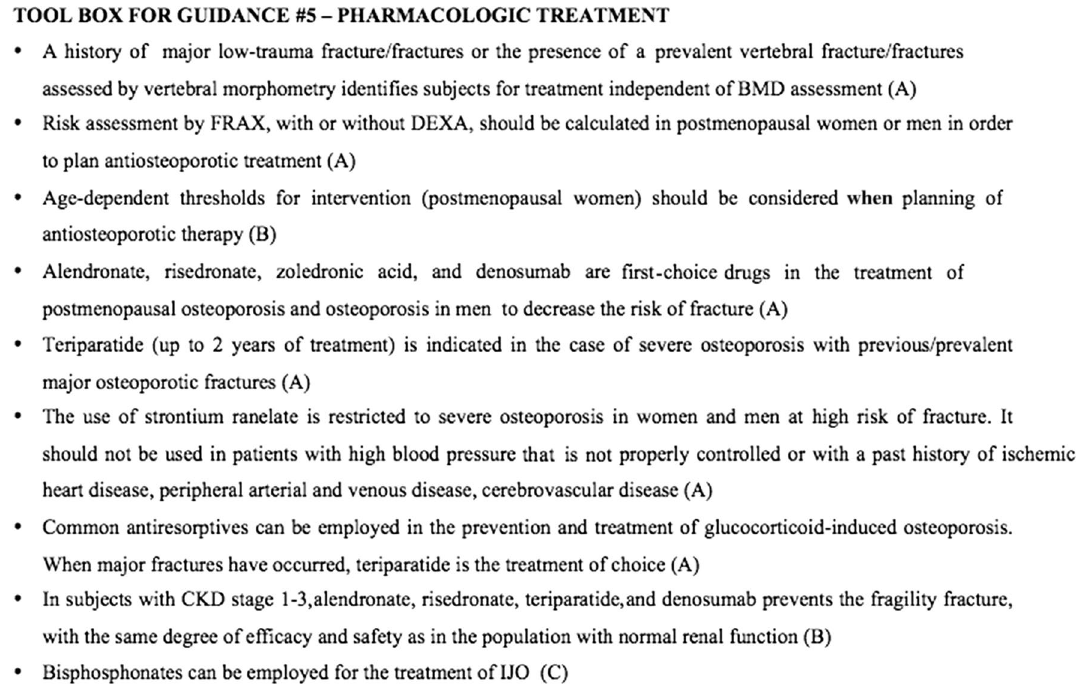
Fig. 6 Toolbox for guidance: pharmacologic